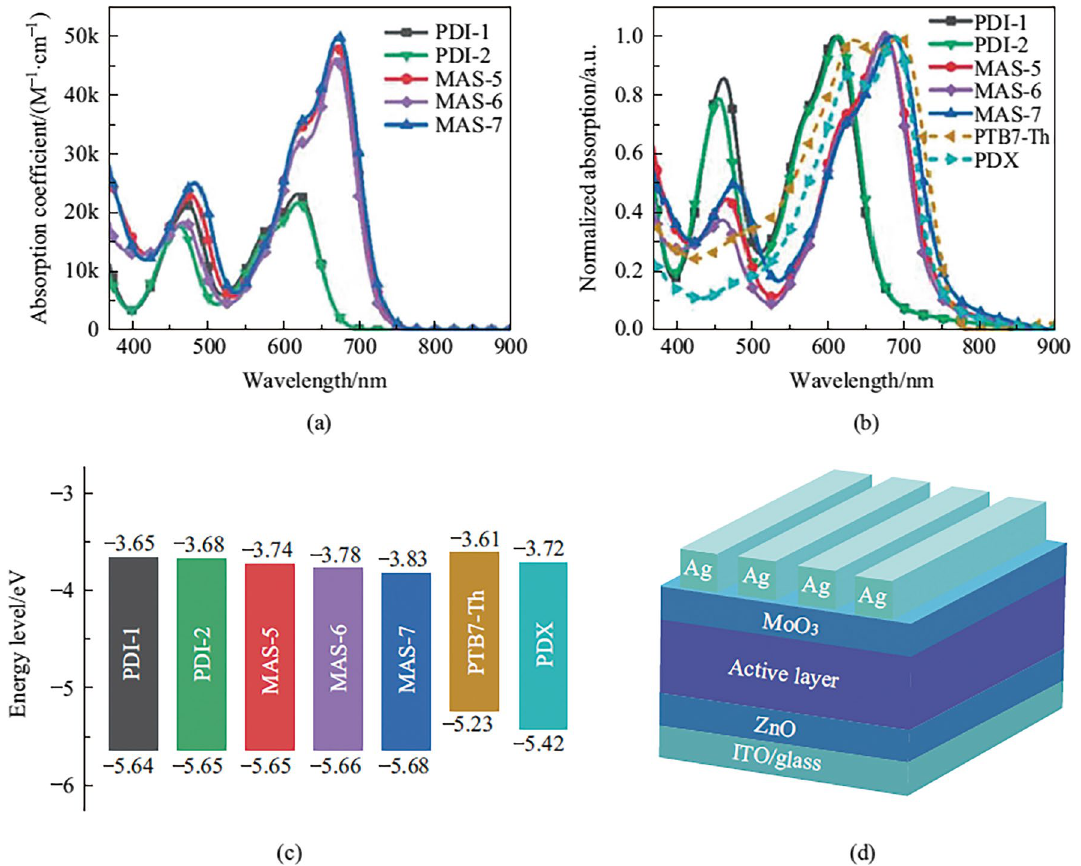
Fig. 2 a UV–vis absorption coefficients of PDI-1 (black line), PDI-2 (green line), MAS-5 (red line), MAS-6 (violet line) and MAS-7 (blue line) in dilute chloroform solution. b Normalized UV–vis absorption spectra of PDI-1, PDI-2, MAS-5, MAS-6, MAS-7 and PTB7-Th (yellow dashed line)/PDX (cyan dashed line) in films. c Schematic diagram of the energy levels of the donor and acceptor materials. d The inverted device struc- ture used in this work.